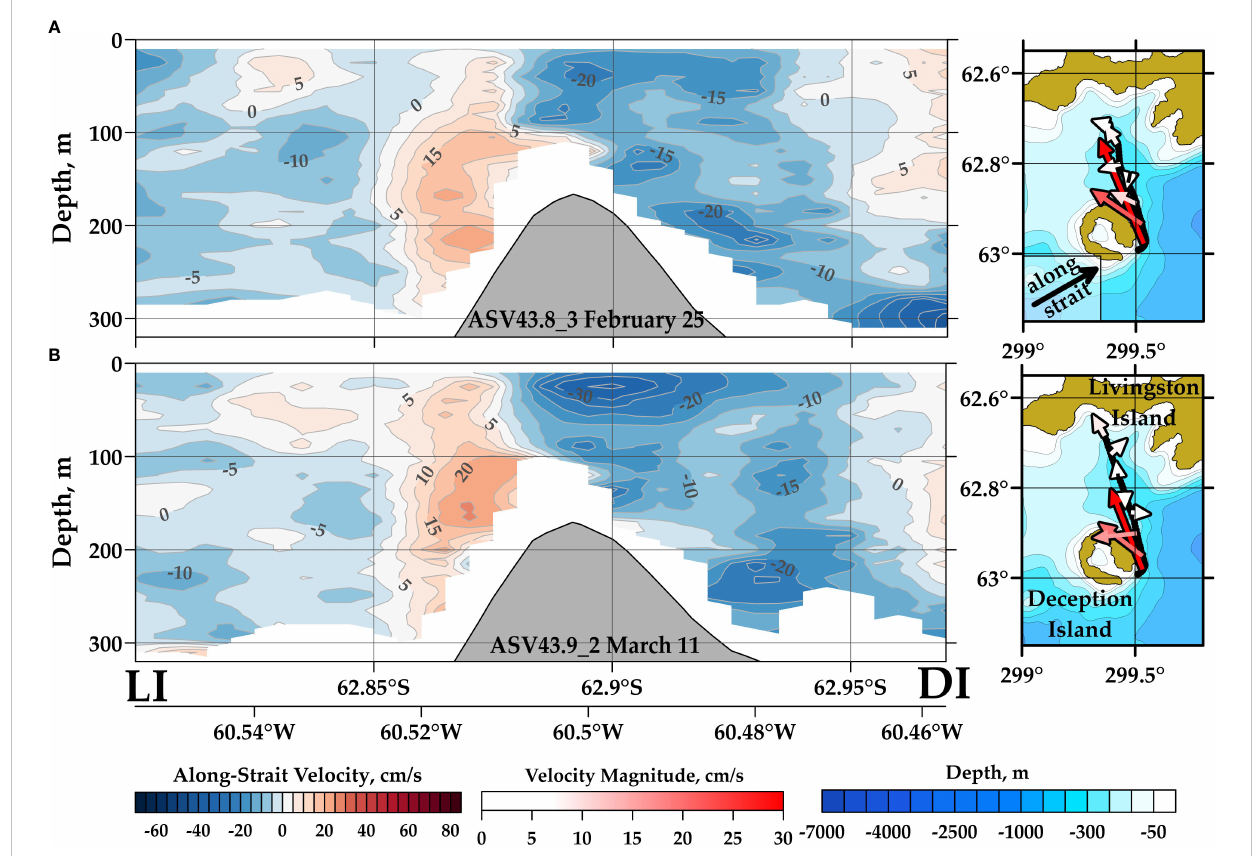
FIGURE 5 Distribution of the along-strait velocity on the section between Livingston and Deception islands based on two SADCP crossings: on February 25 (A) and March 11 (B) of 2017. Positive values of velocity correspond to the east-north-east direction (the exact value is 60° relative to the north; this direction is shown by black arrow in the upper right panel). The velocities were projected to the direction along the strait independently on the orientation of transects. Locations of the crossings are shown in the right panels together with the depth-averaged SADCP velocities. The ocean bottom is shown by grey color. LI, Livingston Island; DI, Deception